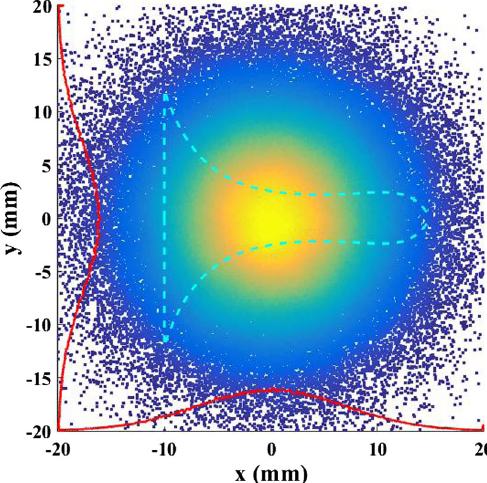
FIG. 4. Density plot of the transverse Gaussian distribution. Red curves on each axis show the projected profile that is Gaussian, and the cyan-dashed curve in the density plot shows the mask shape for the triangular